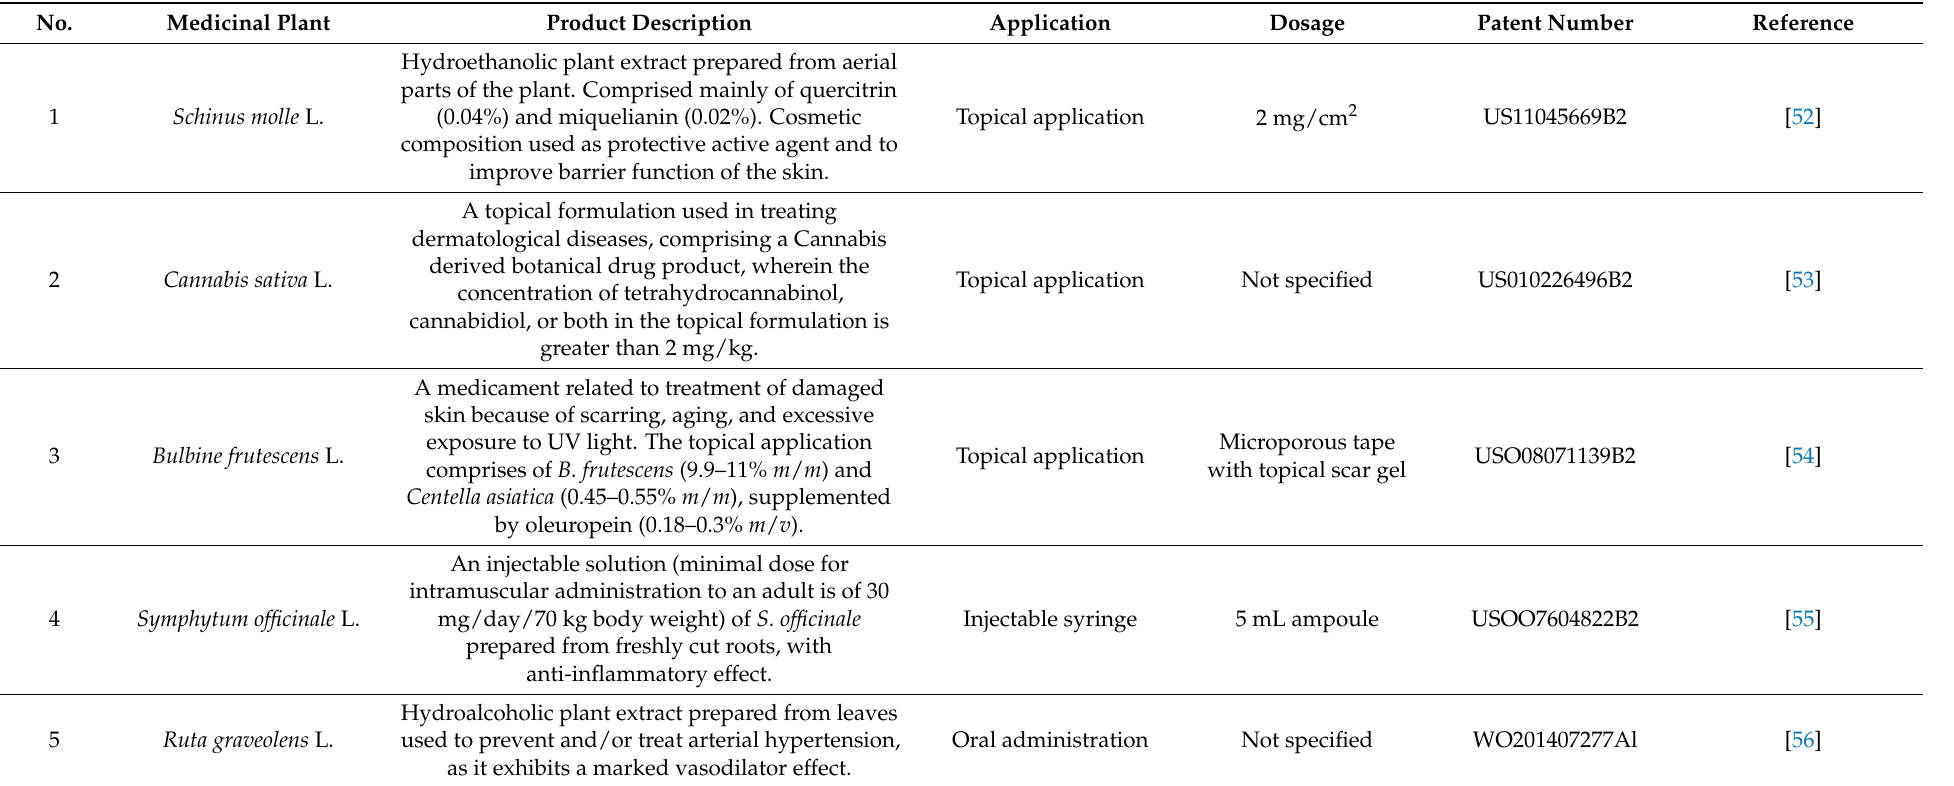
Table 2. Patents/products on medicinal plants with cosmeceutical